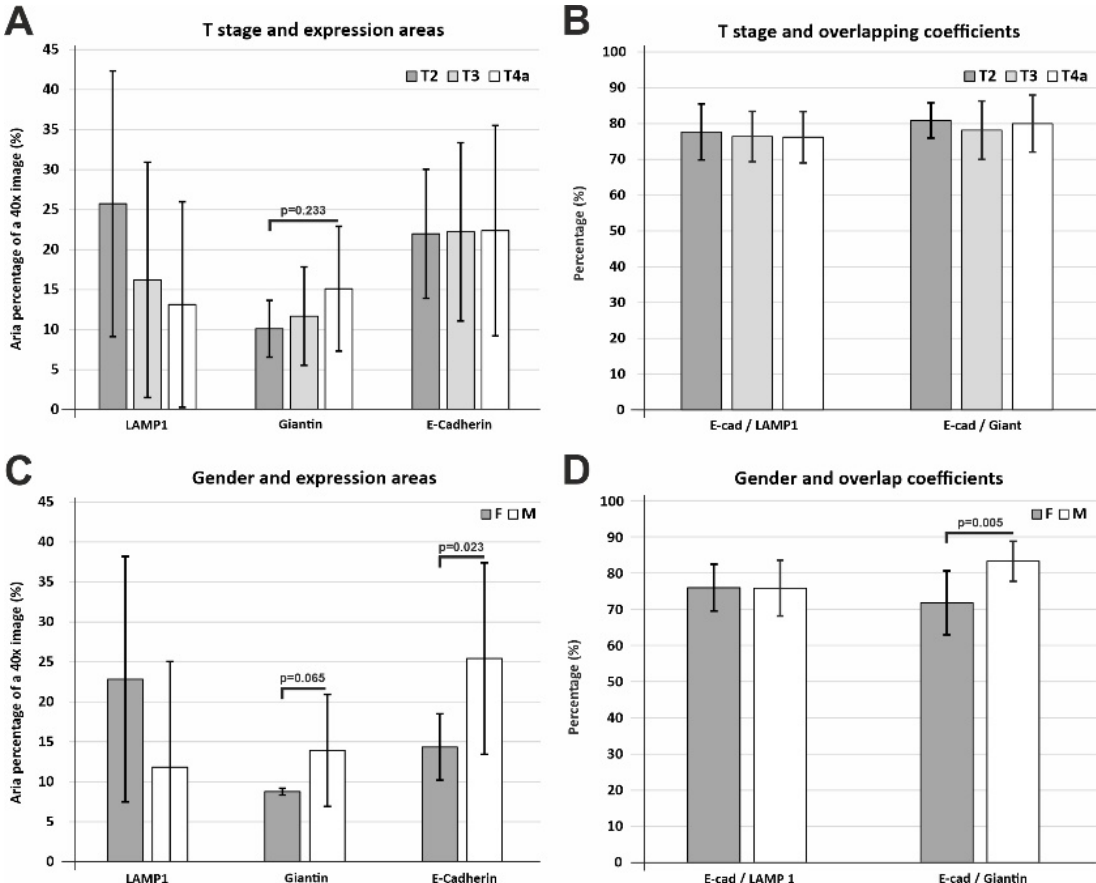
Figure 9. Analysis of T stage and gender denominators. ( A ) LAMP1 and Giantin expression areas show an inverse, albeit statistically non-significant, variation depending on the tumor stage. ( B ) E- cadherin colocalization with LAMP1 and Giantin show no differences when stratified for the three tumor stages. ( C ) Expression areas of the three markers showed that LAMP1 had a tendency for higher values in females, while Giantin and E-cadherin were decreased in females, with E-cadherin variations only showing a significant difference. ( D ) Overlapping coefficients for E-cadherin/LAMP1 do not show any variation depending on the gender of the patients, while E-cadherin/Giantin shows a clear-cut decrease for female patients. Significance is shown for a global ANOVA testing ( A ) and Student’s t-test ( C , D ). Data are expressed as means ±